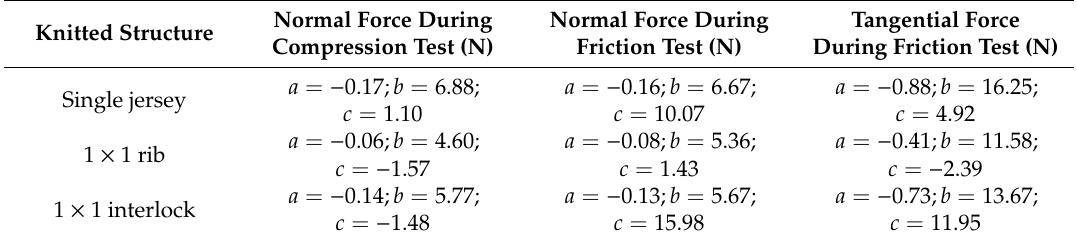
Figure 9. Evolution of the loss of irradiance relative to the applied compression load for the three knitted structures with the error bars representing the standard deviation. The dotted lines correspond to the second order fitting curves. Table 2. Coe ffi cients of the second order polynomial y = ax 2 + bx + c for compression (compression load) and friction tests (normal and tangential loads) for the three knitted structures studied with all the curves R 2 >